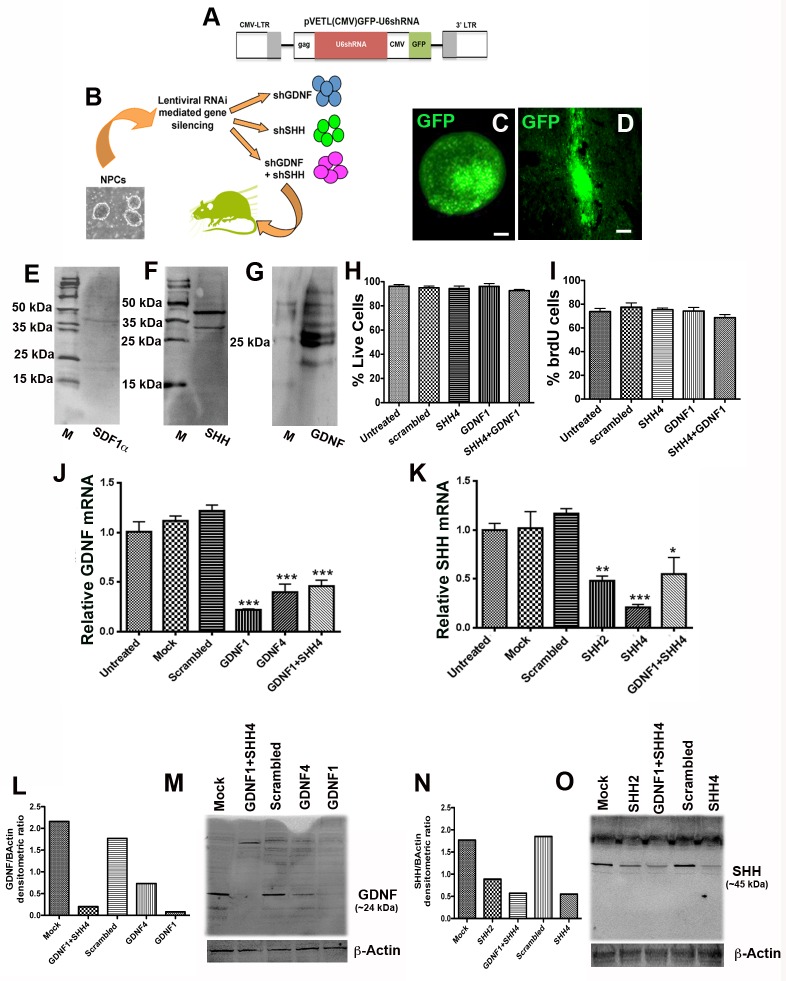

In vitro lentiviral silencing of GDNF and SHH in NPCs.Western blotting analyses of cultured NPCs indicated that the cells expressed only GDNF (~25kda) and SHH (~45kda), but no detectable SDF1α (~11kda), under basal conditions (E-G; GDNF and SHH were run on the same gel and membrane divided, whereas SDF1 was run on a separate gel). Therefore, an FIV based in vitro RNA interference approach was used to knock down the expression of GDNF, SHH or both in donor NPCs before transplantation (B). A schematic diagram of pVETL construct used for expression of shRNAs and the GFP reporter is depicted in (A). After testing, the two most efficient shRNA constructs targeting GDNF or SHH were cloned into a FIV eGFP vector and subsequently infected into the NPCs in culture (D, shows a representative image of in vitro NPCs infected with control eGFP vector). The NPCs did not show a significant change in survival and proliferative ability after the shRNA infections (H, I). When the silencing efficiency of the virally infected shRNA’s was examined through mRNA (qPCR; J, K) and protein (western blot; L-O) analyses, it was determined that in particular the GDNF1 and SHH4 constructs were able to most significantly (p<0.001) inhibit GDNF and SHH expression respectively, when compared to mock (eGFP vector) and scrambled (non-targeted shRNA) controls, and were focused upon in the rest of the study. Image E displays control FIV eGFP expressing NPCs in vivo, 2 weeks after transplantation. Values are expressed as mean ± SEM [*p<0.05, **p<0.01, ***p<0.001 compared to scrambled control, one-way ANOVA with Tukey’s post hoc test]. Scale bars: A, B, C (in C)– 25 μm; D, E—100 μm.